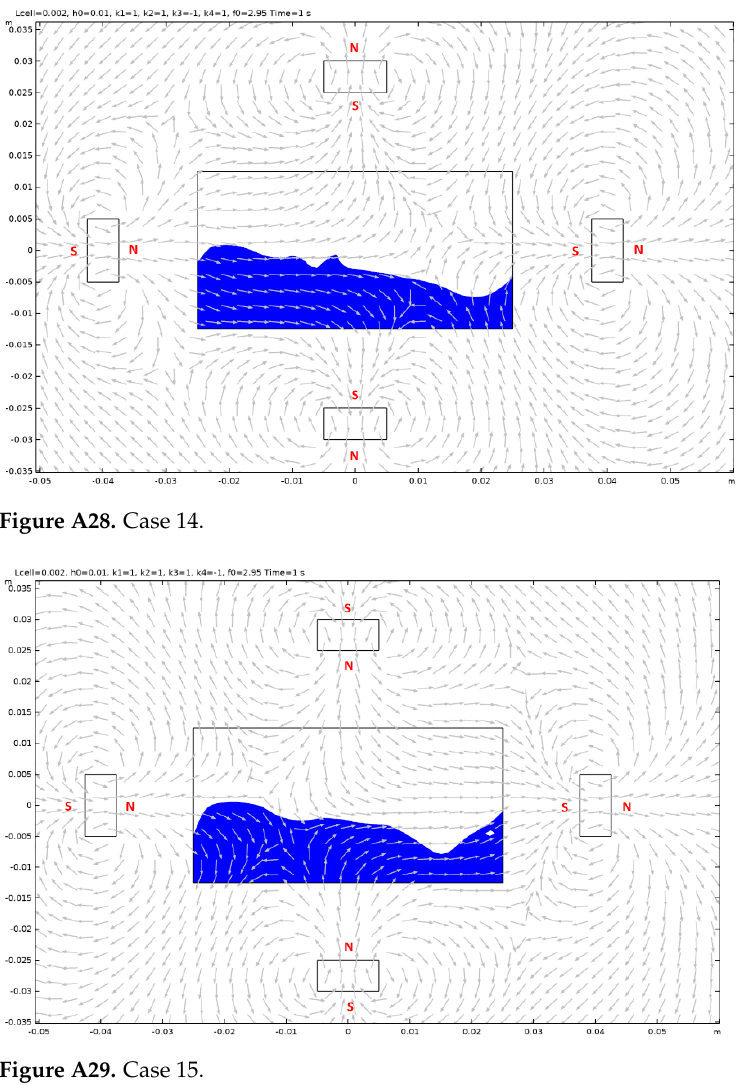
Figure A27. Case 13.